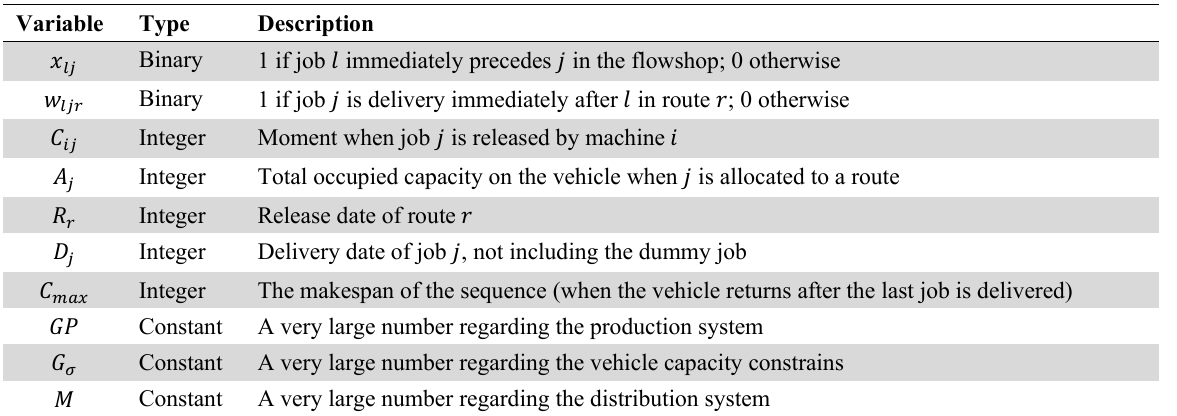
Variables and constants used to define a solution